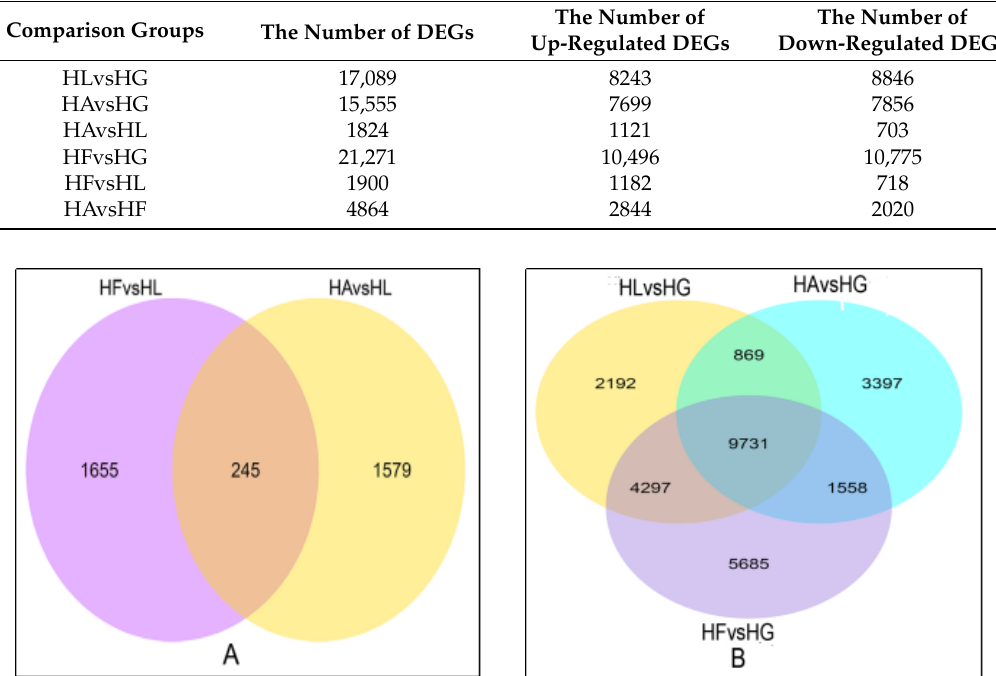
Figure 5. Venn Diagram of DEGs (differentially expressed genes). ( A ) was the comparison of DEGs in HAvsHL and HFvsHL; ( B ) was the comparison of DEGs in HLvsHG, HAvsHG and HFvsHG.